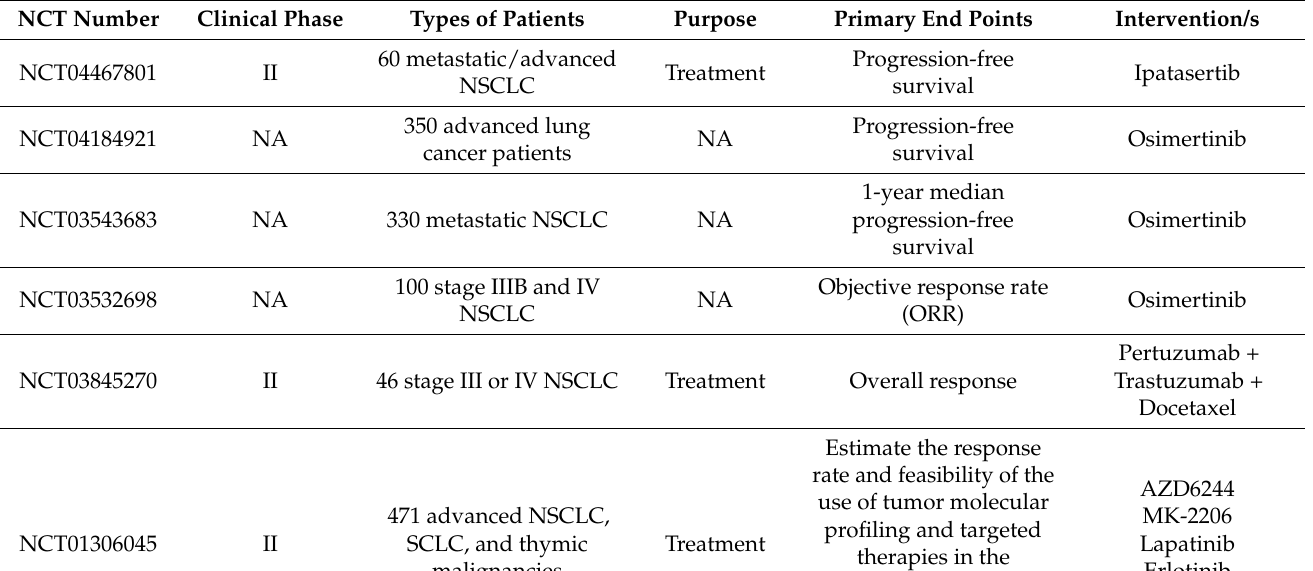
Table 4. Ongoing clinical trials are investigating treatments targeting the AKT–PI3K–mTOR pathway in